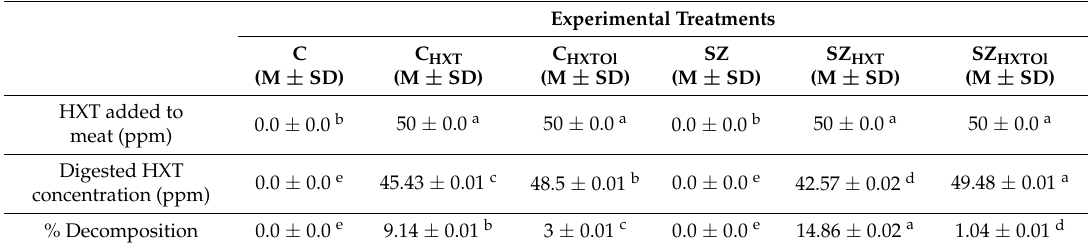
Table 4. HXT concentration in emulsions (soluble fraction added to Caco-2 cells) measured by HPLC. Experimental Treatments C C HXT (M ± SD) (M ± SD) HXT added to 0.0 ± 0.0 b meat (ppm) Digested HXT concentration